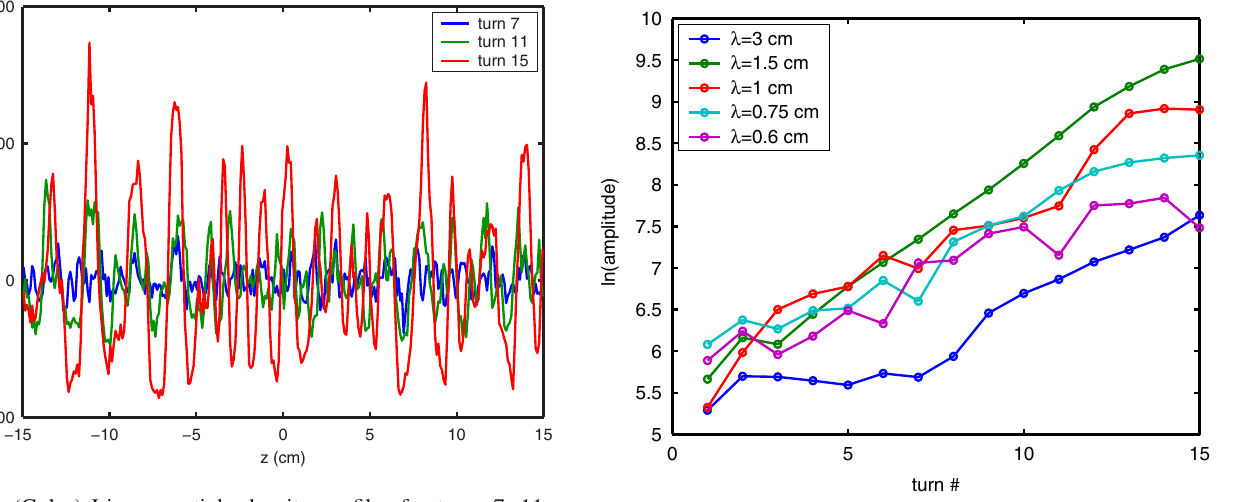
FIG. 9. (Color) Logarithm of the amplitude of harmonics with (cid:9) ¼ 0 : 6 , 0.75, 1, 1.5, and 3 cm as a function of turn number. The harmonic with (cid:9) ¼ 1 : 5 cm exhibits the highest growth